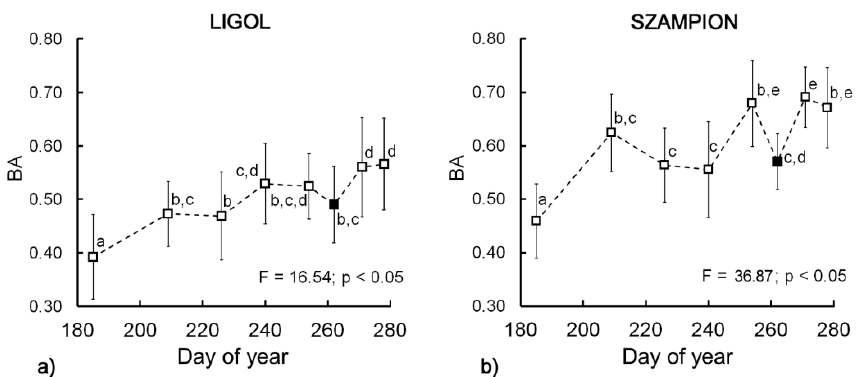
Figure 3. Biospeckle activity changes during ( a ) “Ligol”; and ( b ) “Szampion” apple development and maturation. Bars represent standard deviations. The superscript letters denote no significant differences at p < 0.05. The filled square marker indicates optimum harvest date.